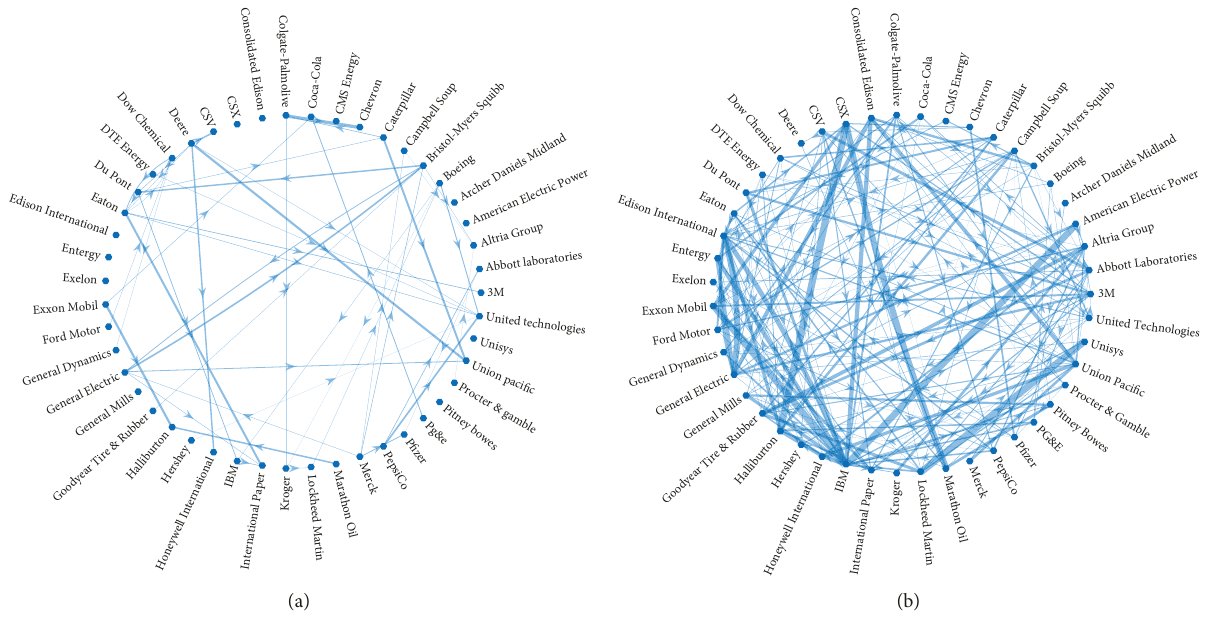
Figure 4: Estimated dependency network of 47 long-established constituents of the S&P 500 index, estimated using daily stock returns, corresponding to distinct periods in time: a period of stable market growth from 1994 to 1996 (a) and the Dot-com bubble and crash from 1999 to 2001 (b). Arrows on the lines denote the direction, and thickness represents the amount of the estimated causality between stocks.